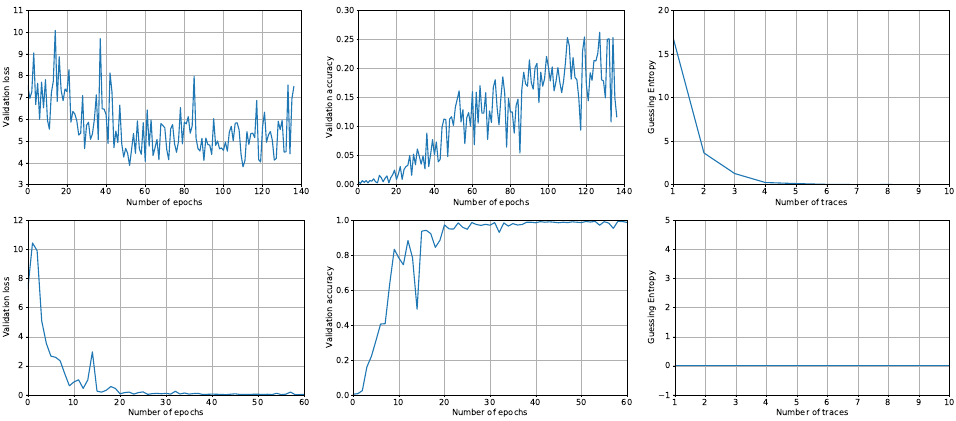
Figure 6: Results of DPA contest v4.1, with (bottom) and without (top) the knowledge of mask value.